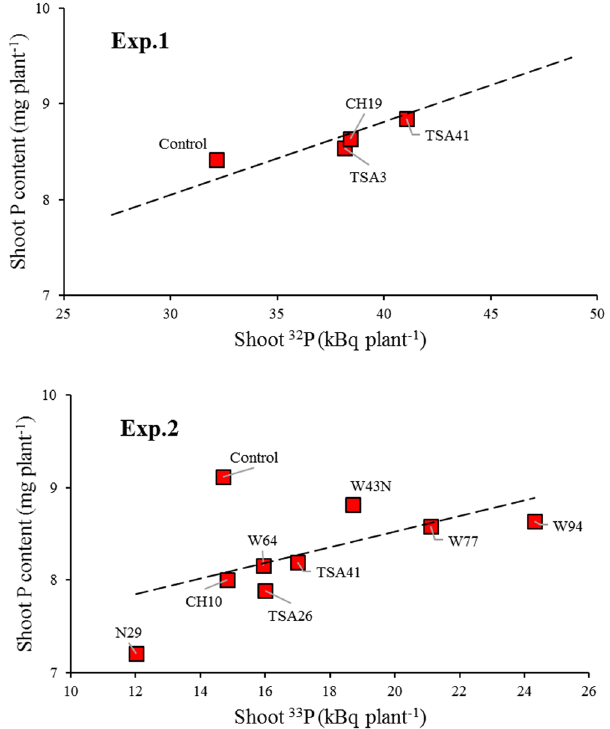
Figure 3. Linear relationship between total 32 P/ 33 P and total P content of mycorrhizal Z. mays L. genotype Oh43 inoculated with R. irregularis in combination with different bacterial strains. Result of the regression analysis is as follows: Exp. 1, y = 0.077x + 5.748, R² = 0.535; Exp. 2, y = 0.085x + 6.831, R² = 0.303. For abbreviations see Table